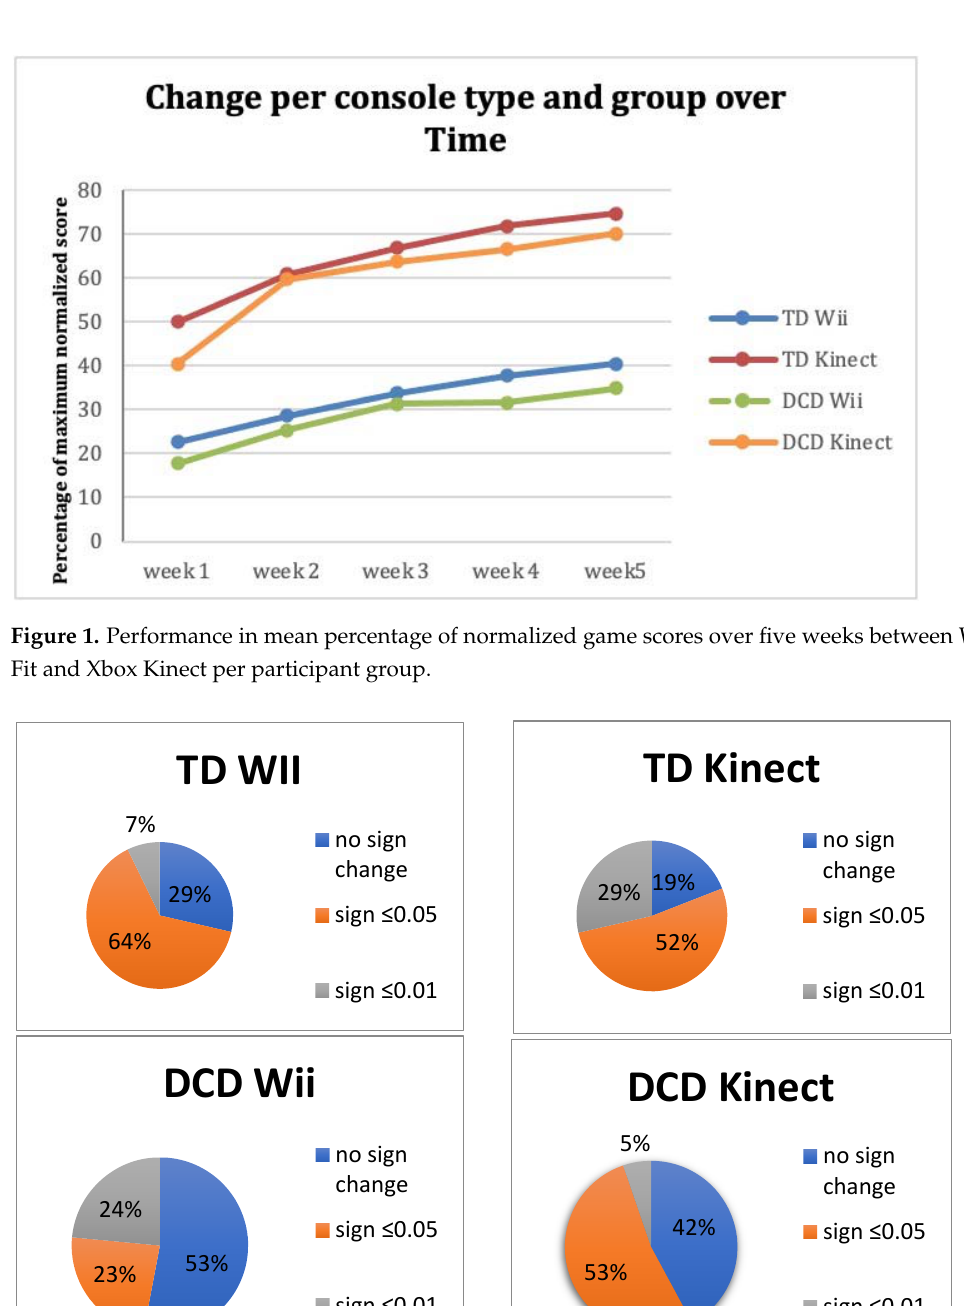
Figure 2. Percentage of individual classification of rate of improvement in based on the best score of the five games played ten times per console per participant group, indicating the percentage of children with no significant change and significant change at ≤ 0.05 or ≤ 0.01